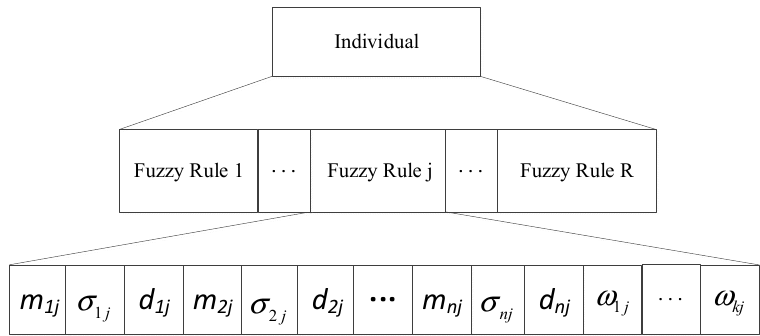
Figure 4. Coding format of the vector.